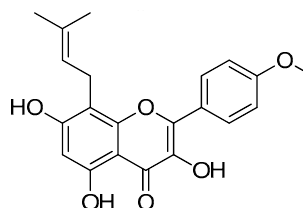
Figure 9. Figure 9. Icaritin.